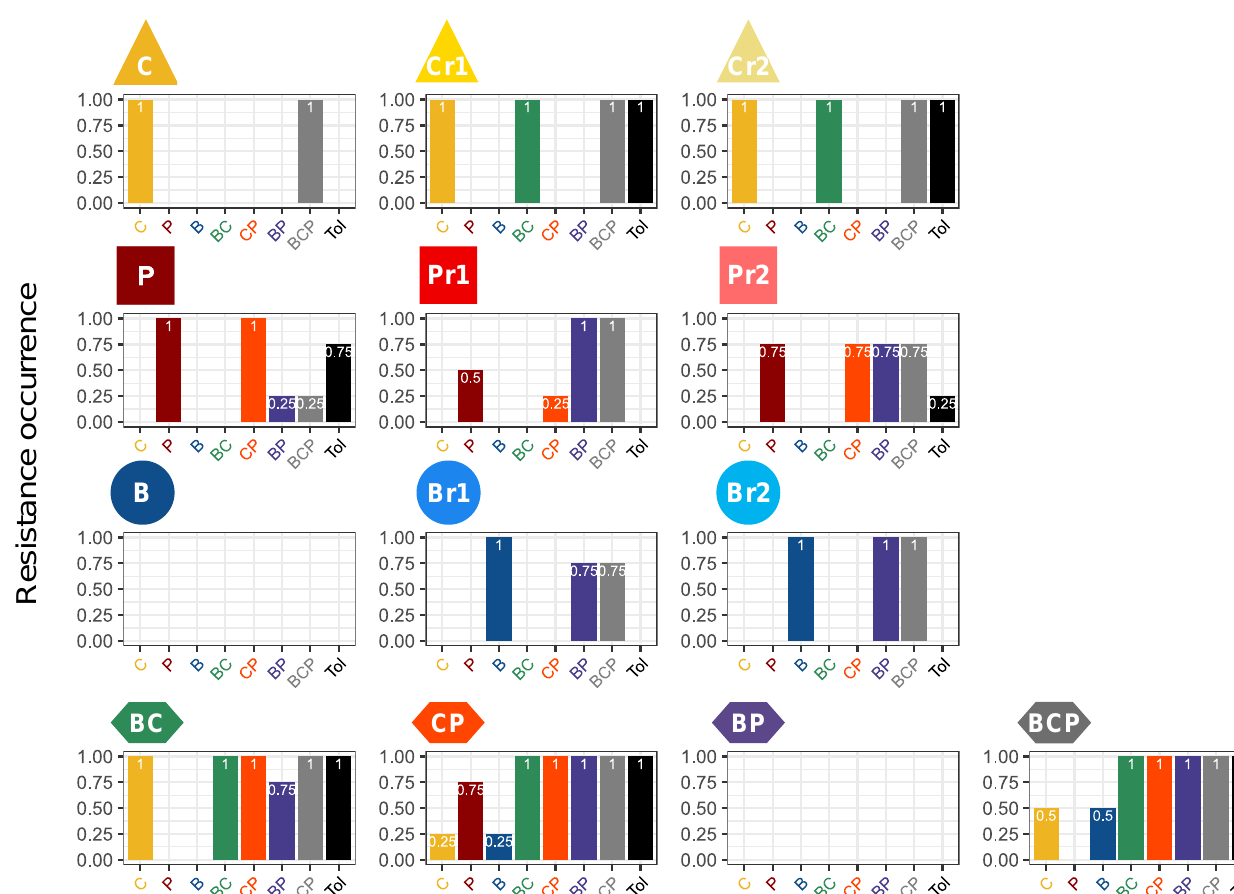
Figure 5. Occurrence of resistance during evolution under each selection regime. The histograms show the occurrence of resistance within a line for each modality in the droplet test. For example, a score of 0.25 means that one of the four replicated lines of this selection regime had a resistance score above zero.